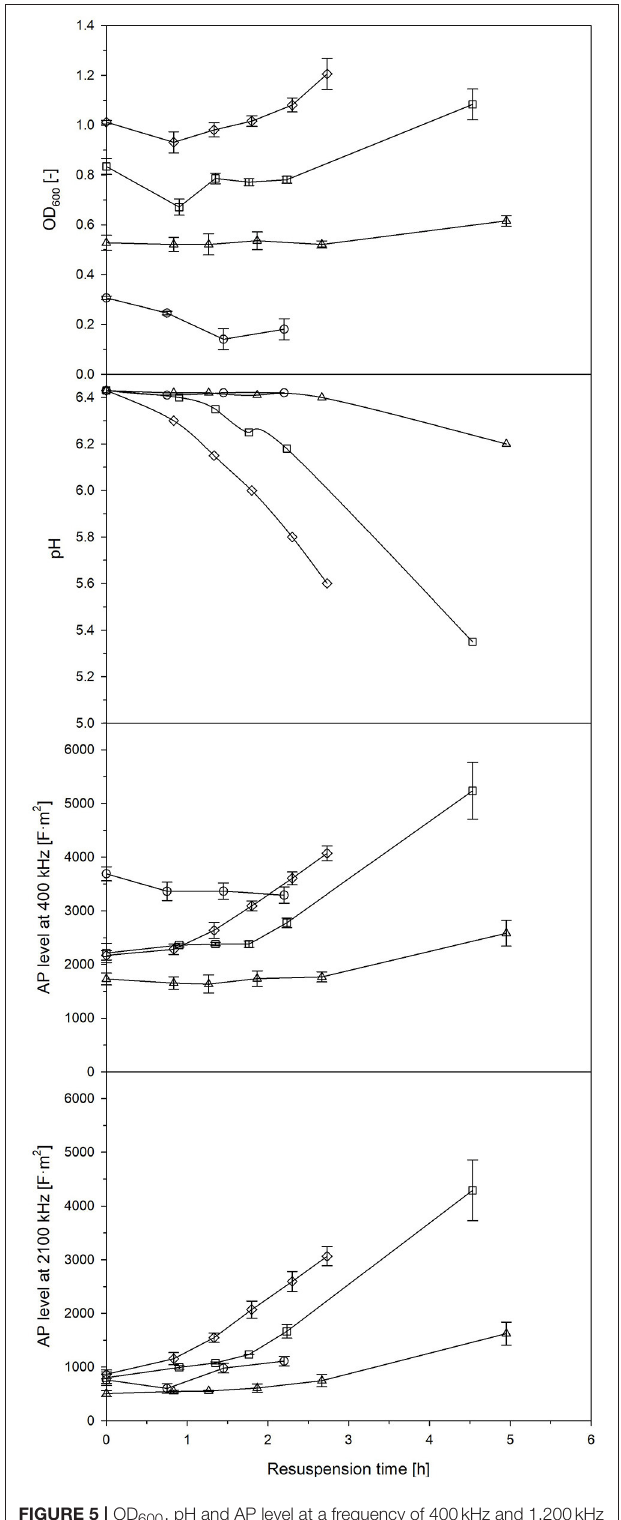
FIGURE 5 | OD 600 , pH and AP level at a frequency of 400kHz and 1,200kHz of formerly freeze-dried and resuspended L. plantarum culture broth in 50% MRS media collected after 4h ( ◦ ), 6h ( (cid:3) ), 8h ( △ ) and 21h of batch cultivation ( ♦ ). Error bars: Mean ± SD ( n =